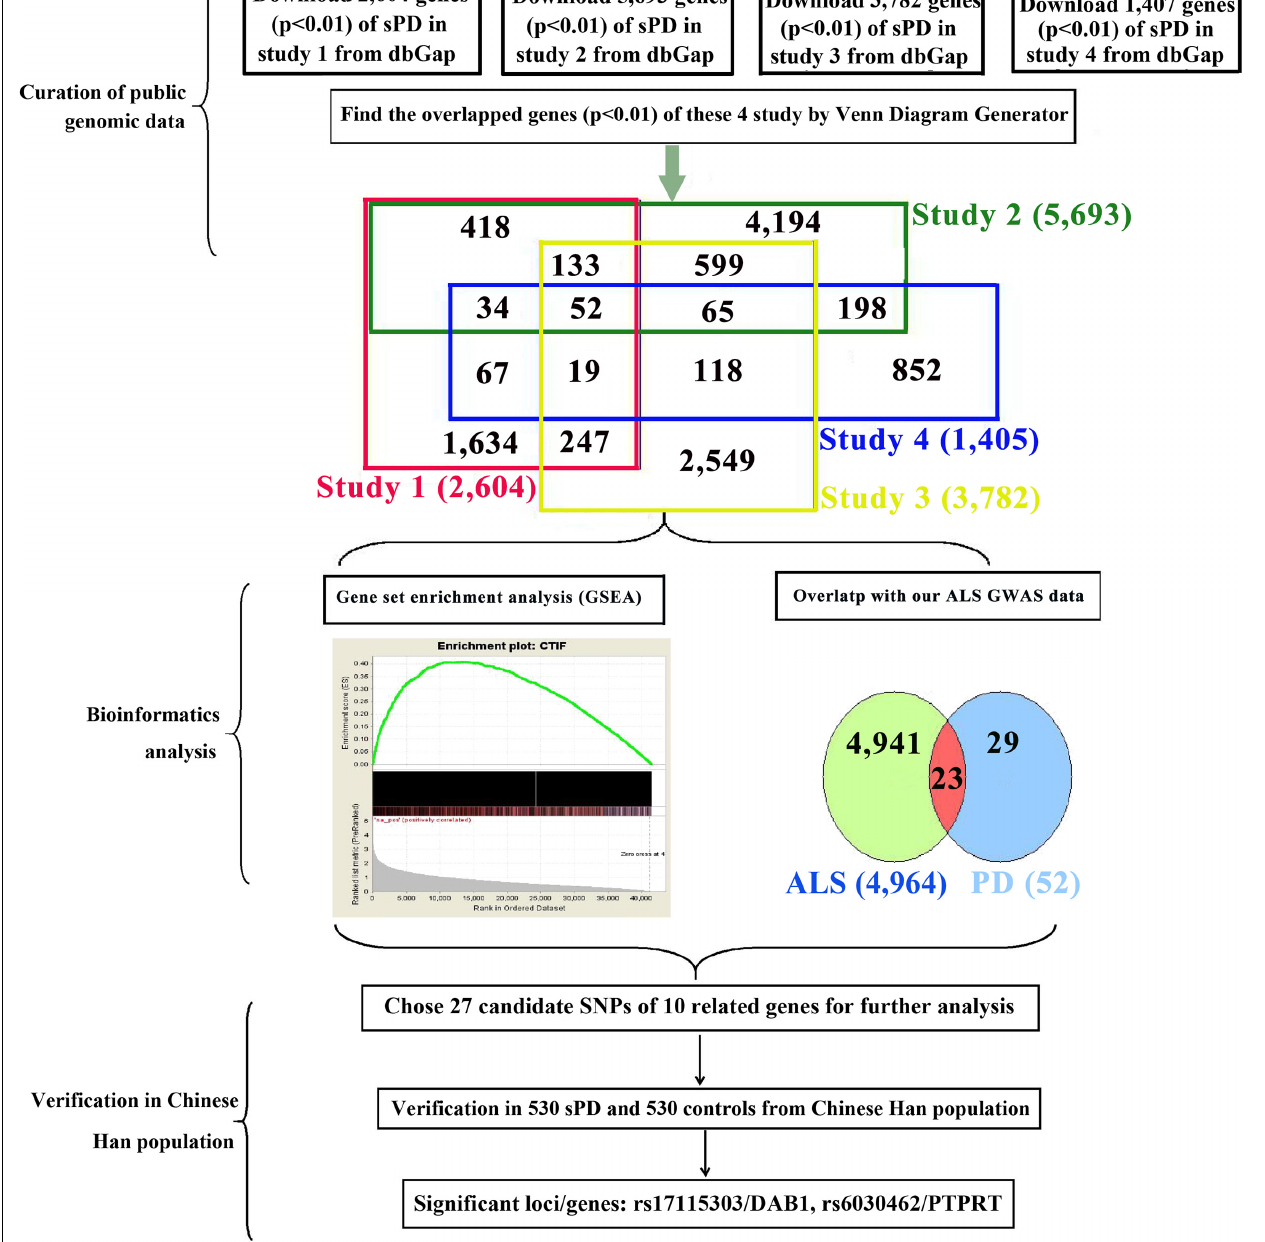
FIGURE 1 | Study design and procedures. To identify common pathogenic genes between sPD and sALS, we downloaded four independent GWAS datasets from the dbGap database of the NCBI, mapped all SNPs to genic regions, and then preformed an integrative analysis to scan for common genetic factors related to sPD. We also compared the 52 candidate genes with our previous sALS data from a GWAS of the HPMC and found 23 that were significant in both sPD and sALS. We selected 27 loci in 10 related genes for validation in an independent cohort of 530 sPD patients and 530 neurologically normal control subjects at the Affiliated Hospital of Nanchang University. DAB1 rs17115303 and PTPRT rs6030462 were identified as being closely associated with both sPD and sALS. sPD, sporadic Parkinson’s disease; sALS, sporadic amyotrophic lateral sclerosis; GWAS, genome-wide association study; NCBI, National Center for Biotechnology Information; SNPs, single-nucleotide polymorphisms; HPMC, Han population of mainland